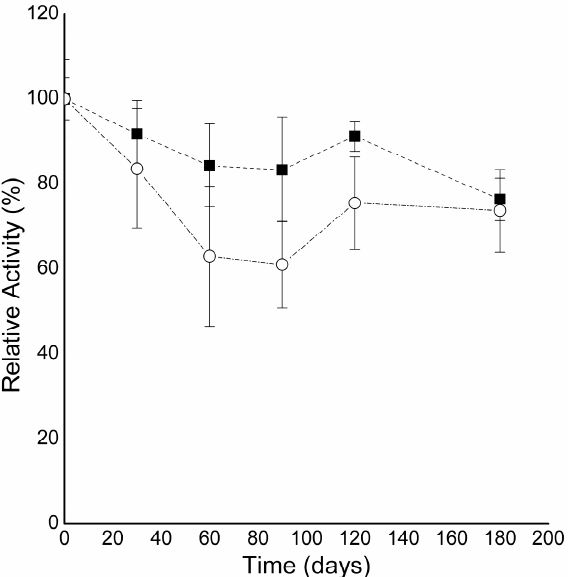
Figure 5. Evaluation of the quality of immobilized ALDC dehydrated during the storage of immobilized ALDC. ( ) Lyophilized and ( ○ ) vacuum dried. Error bars represent the standard deviation from the mean of three independent experiments.